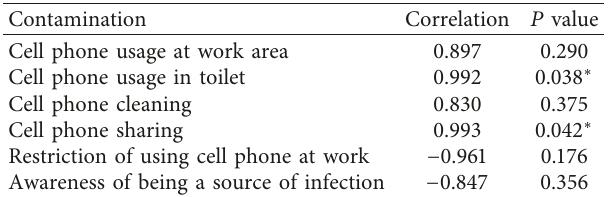
Table 3: Correlation between contamination of cell phone and questionnaire